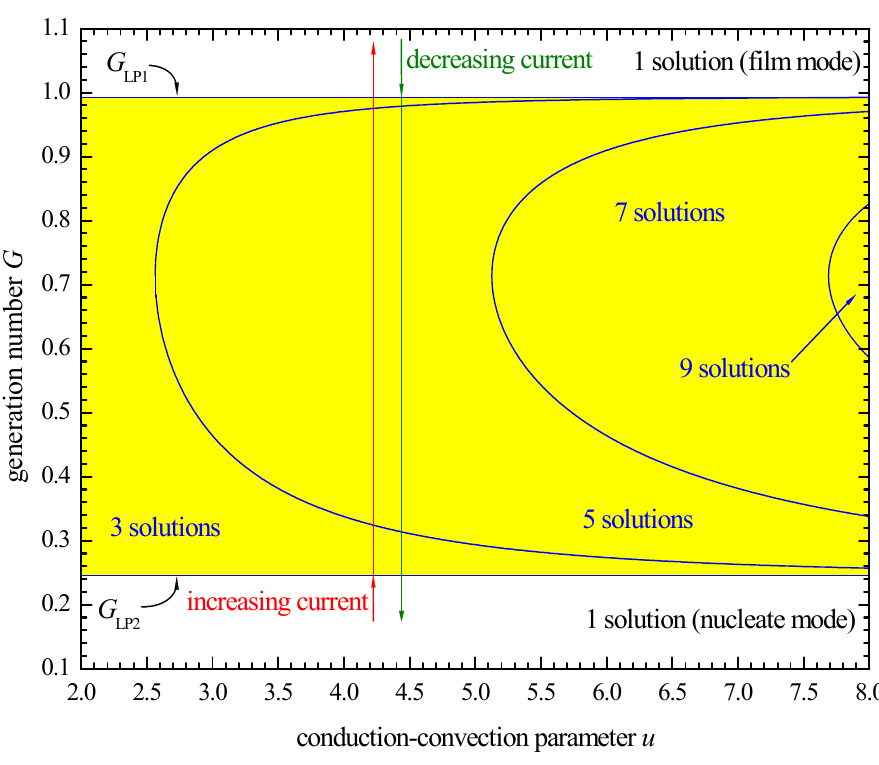
Figure 1. Projection of the singular points on the ( u , G ) plane.